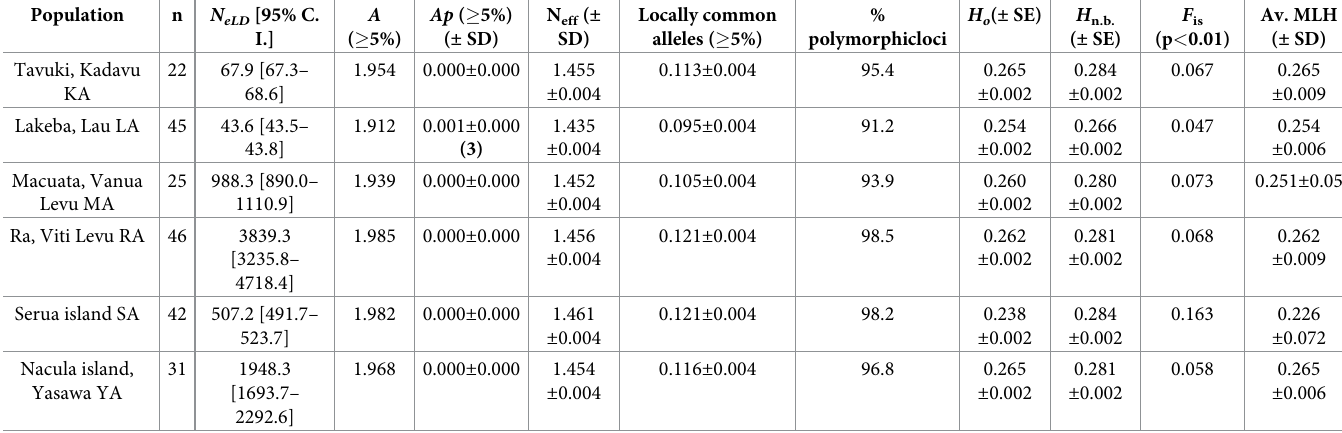
Table 1. Genetic diversity indices and relatedness computed for the Holothuria scabra populations sampled. Parameters calculated include the effective population size by the linkage disequilibrium method ( N eLD ; 95% confidence intervals indicated within brackets), mean number of alleles per locus ( A ), standardised private allelic richness ( Ap , MAF � 5%): The total number of loci with private alleles detected per population is shown in bold, effective number of alleles (N eff ), number of locally com- mon alleles (MAF � 5%) found in < 50% of all 6 populations tested, percentage of polymorphic loci, observed heterozygosity ( H o ), average expected heterozygosity cor- rected for population sample size ( H n.b. ), inbreeding coefficients ( F is ) and average individual multi-locus heterozygosity (MLH). All computations were generated using a dataset containing 6,896 genome-wide SNPs.